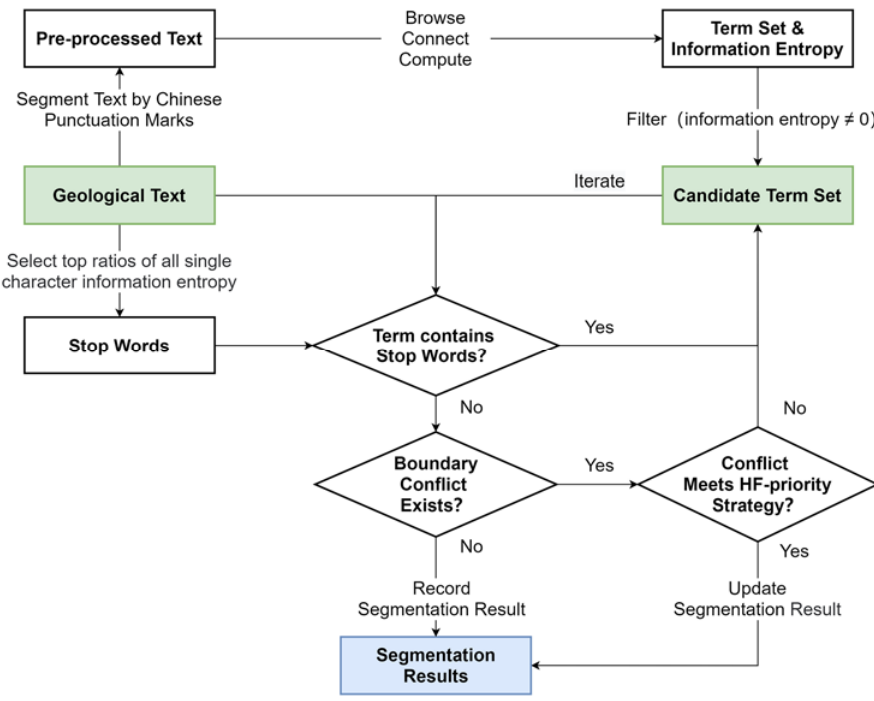
Figure 1. Technical route of Chinese geological text segmentation based on information entropy.